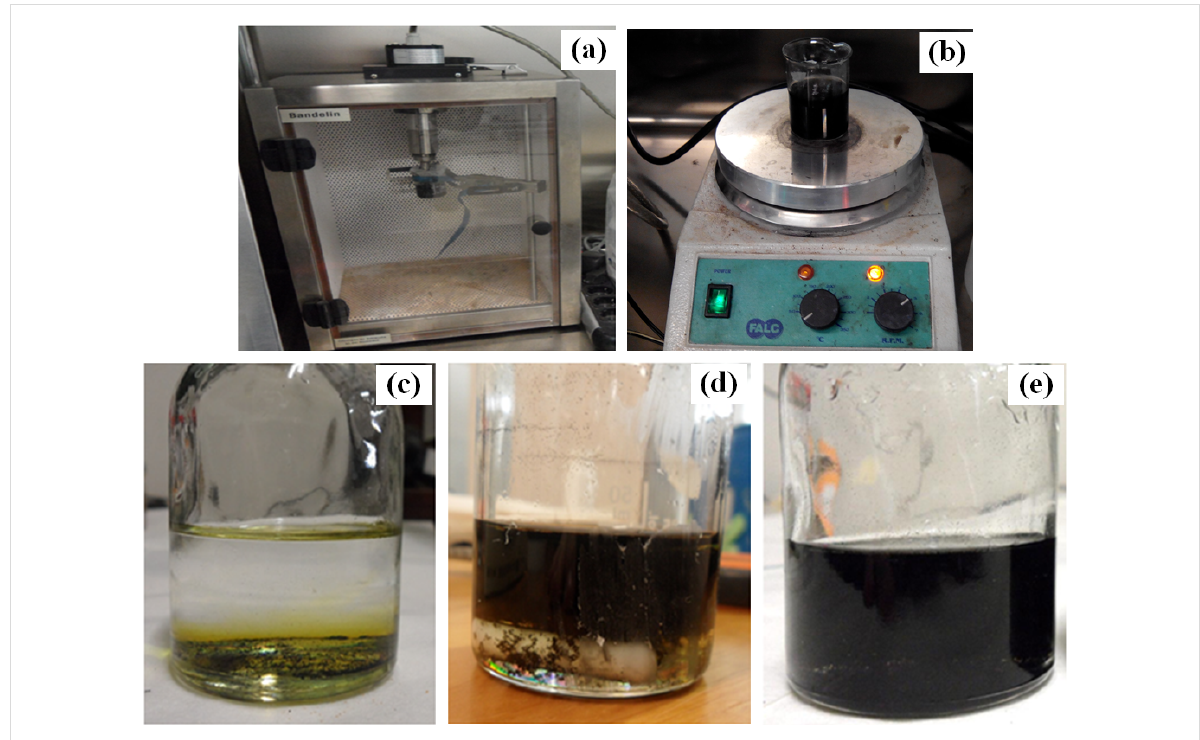
Figure 4: Image of sonicator probe Sonopuls Bandelin HD 2070 during the sonication treatment (a) and magnetic stirrer (FALC F70 model) to disperse the sample and obtain a more homogeneus solution (b). MWCNT/ferrocene mixture in toluene, before the treatment (c), after ten minutes of sonication and other ten minutes of magnetic stirring (d) and after another sonication for ten minutes (e).